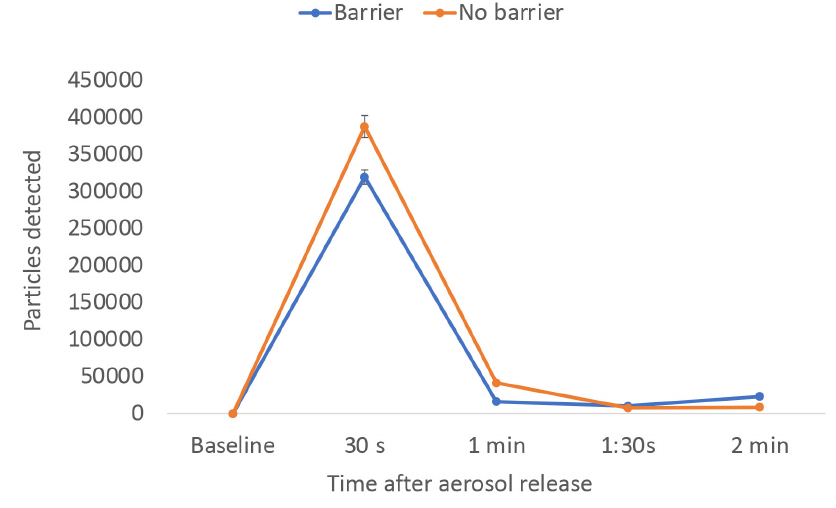
Figure 2B. Minimally effective barrier.